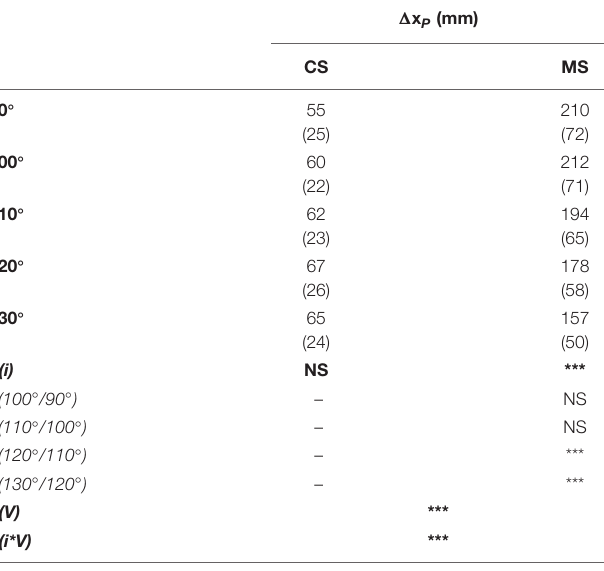
TABLE 6 | (cid:49) x P values for the 5 inclination conditions and for in the 2 speed conditions: comfortable speed (CS) and maximal speed (MS).